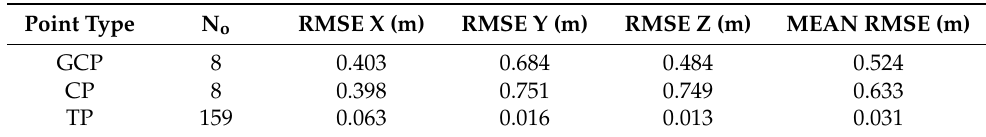
Table 2. RMSE reported for GCPs, CPs and TPs used for the creation of the WV-1-derived DSM of study